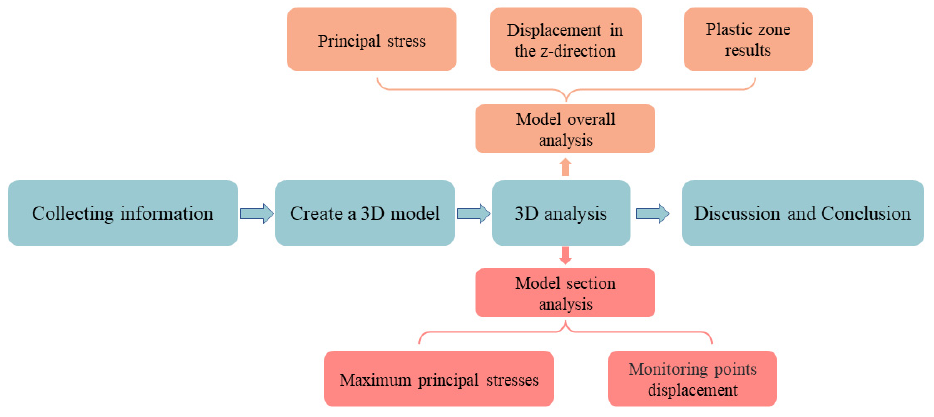
Figure 4. Three ‐ dimensional analysis flow chart. Figure 4. Three-dimensional analysis flow